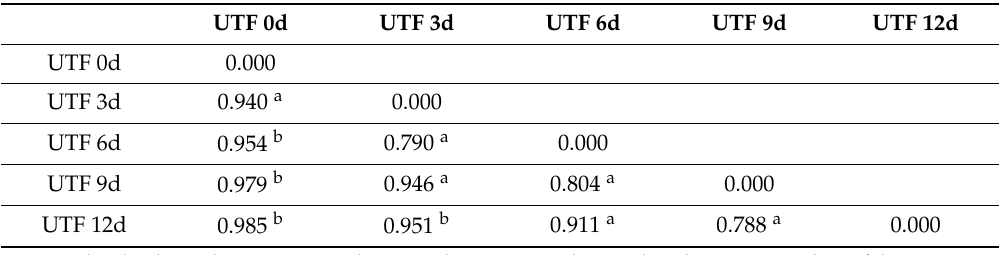
Table 3. Correlation Matrix among the uncoated trout fillets (UTF). The numbers indicate the discrimination indexes.